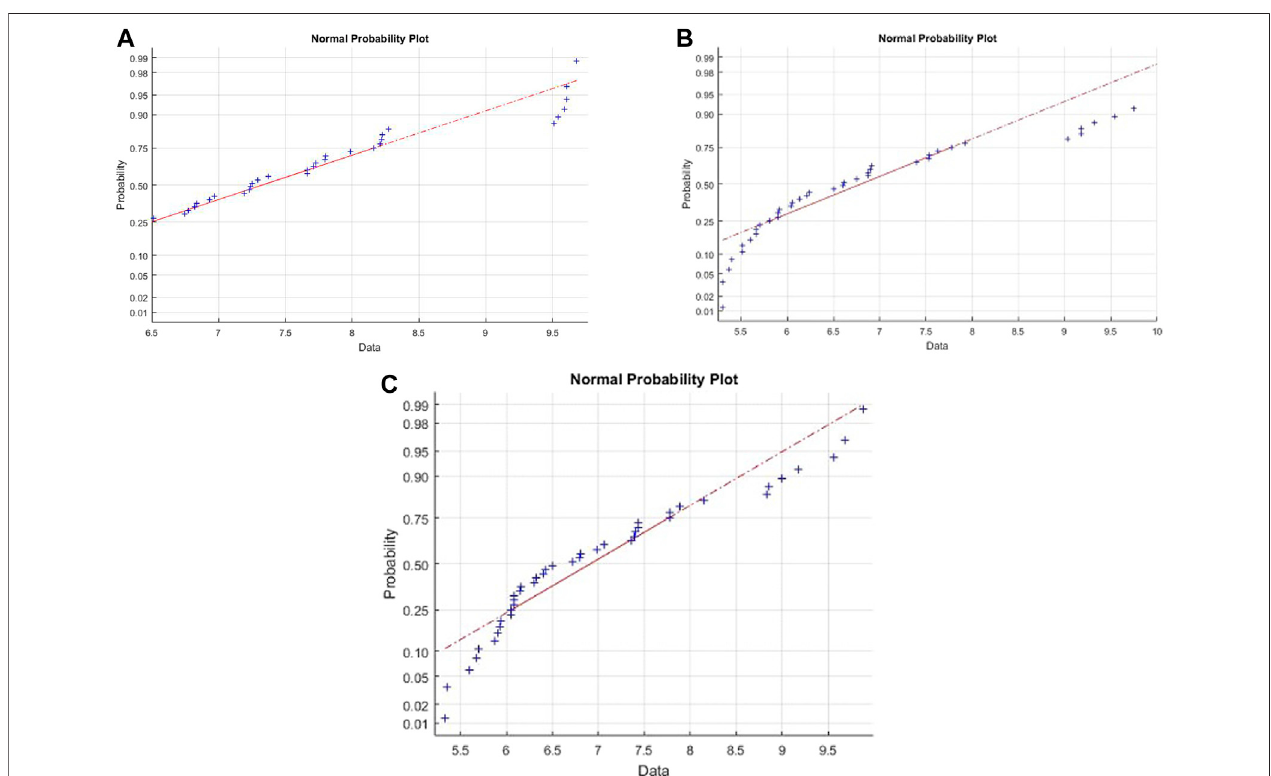
FIGURE 4 | Normal probability for (A) L. plantarum ; (B) L. casei ; (C) co-cultures of L. plantarum and L. casei